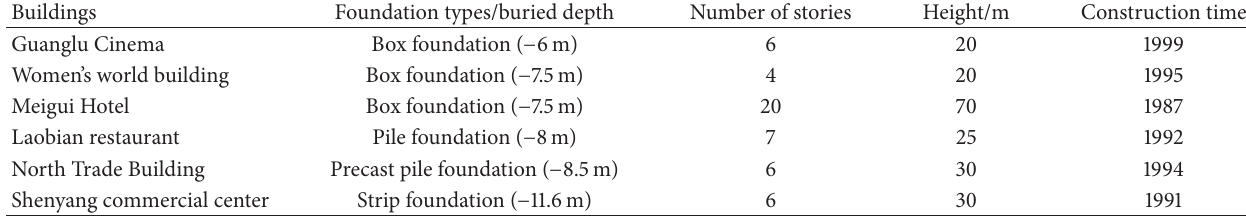
Table 2: Detailed conditions of surface buildings.